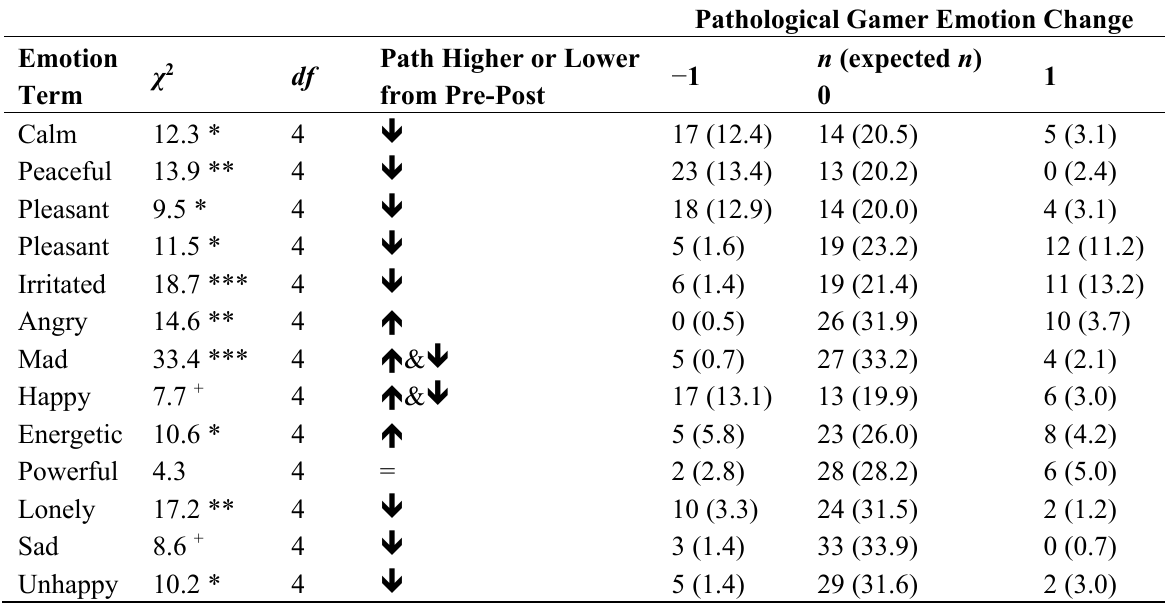
Table 5. Differences in emotional reactivity to playing video games (Study 3). Pathological Gamer Emotion Change